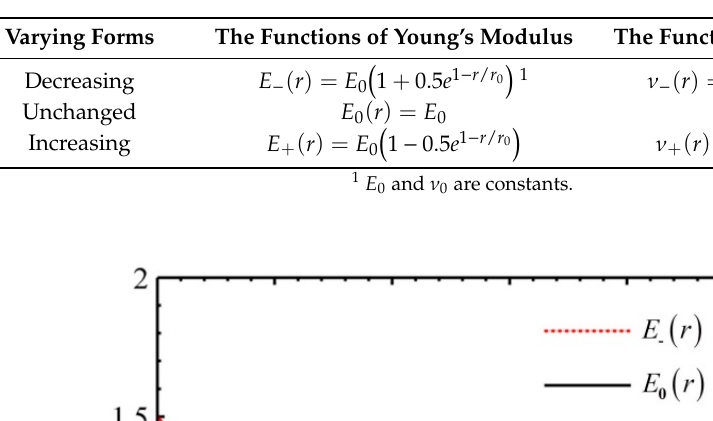
Table 1. Three different functions of Young’s modulus and Poisson’s ratio in the functionally graded material (FGM) plate.